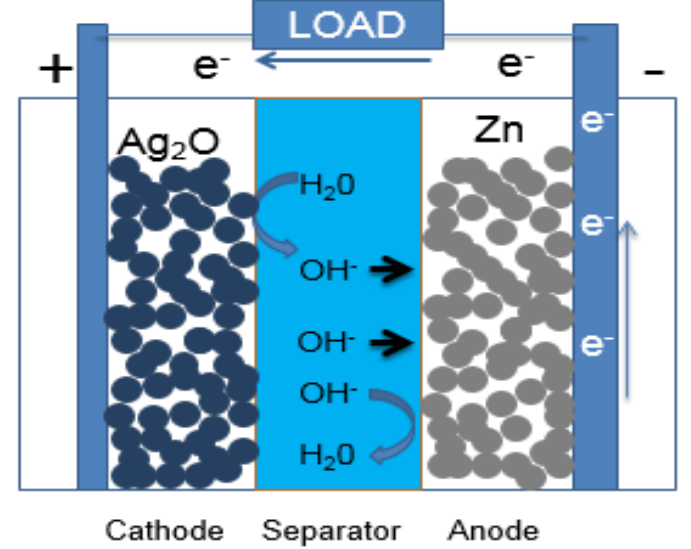
Figure 1. Zinc-silver battery with porous electrodes during discharge.